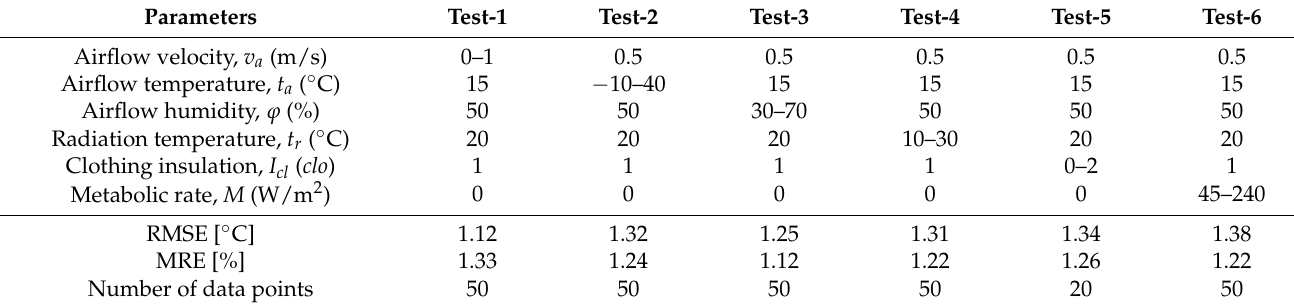
Table 8. Range of input and target parameters based on 150 random test data